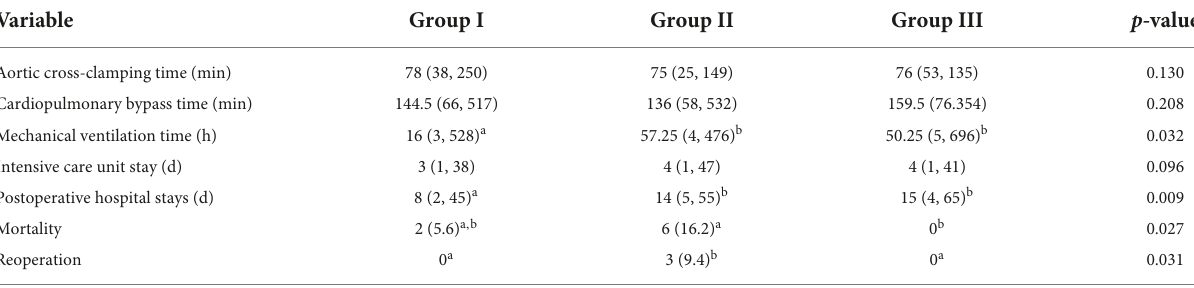
TABLE 3 Surgical